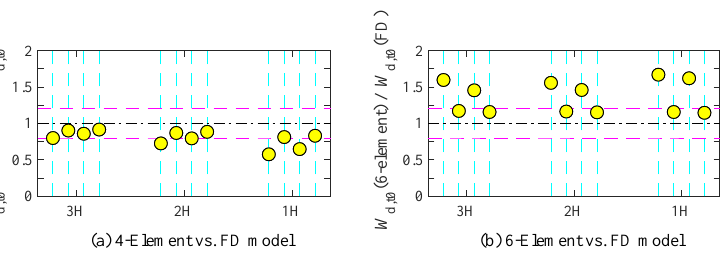
Figure 22. Ratio of the total accumulated energy dissipation of the VE dampers (along-wind): (HH, SH, HS, SS from left to right of each